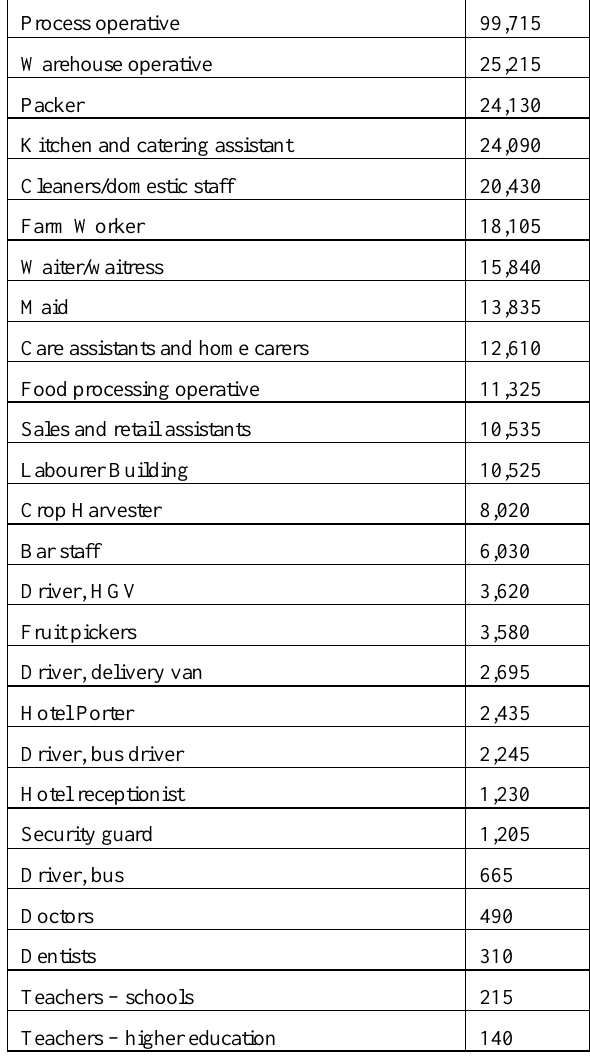
Table 5. Numbers of workers employed in selected